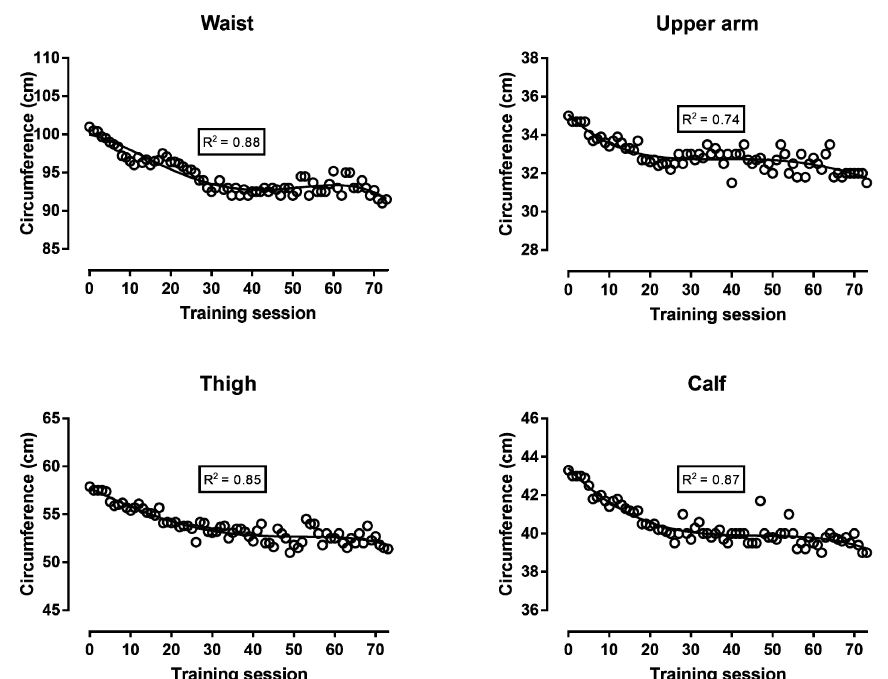
Figure 3. Waist, upper arm, thigh, and calf circumference in absolute values during the preparation for a 48-hour ultra-marathon run.